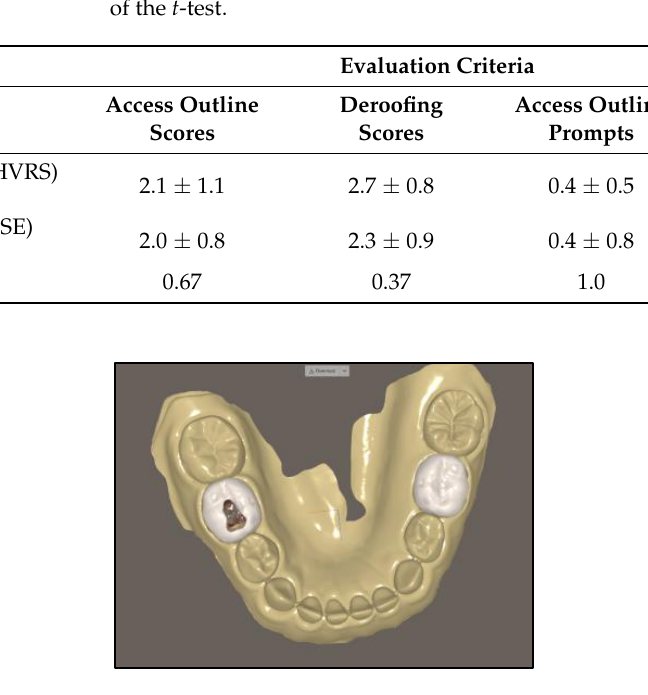
Figure 3. Virtual tooth pulpotomy.